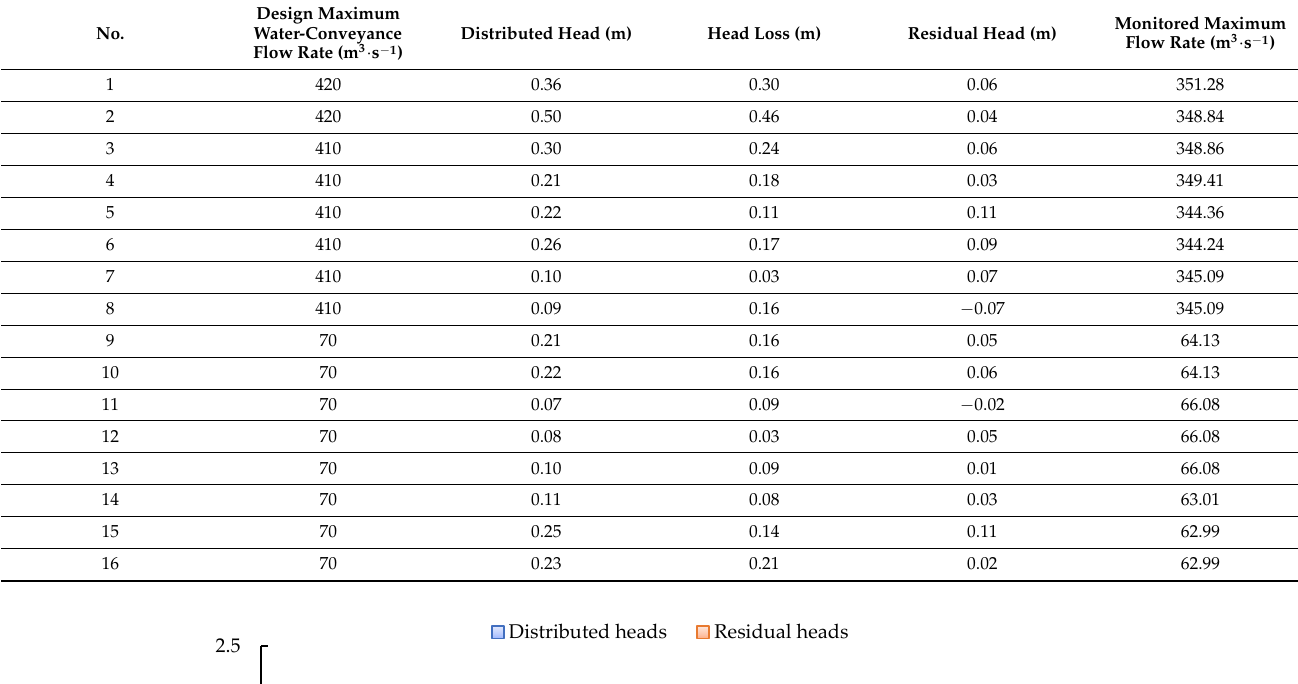
Table 3. Calculation results of head losses of crossing water-conveyance structures.